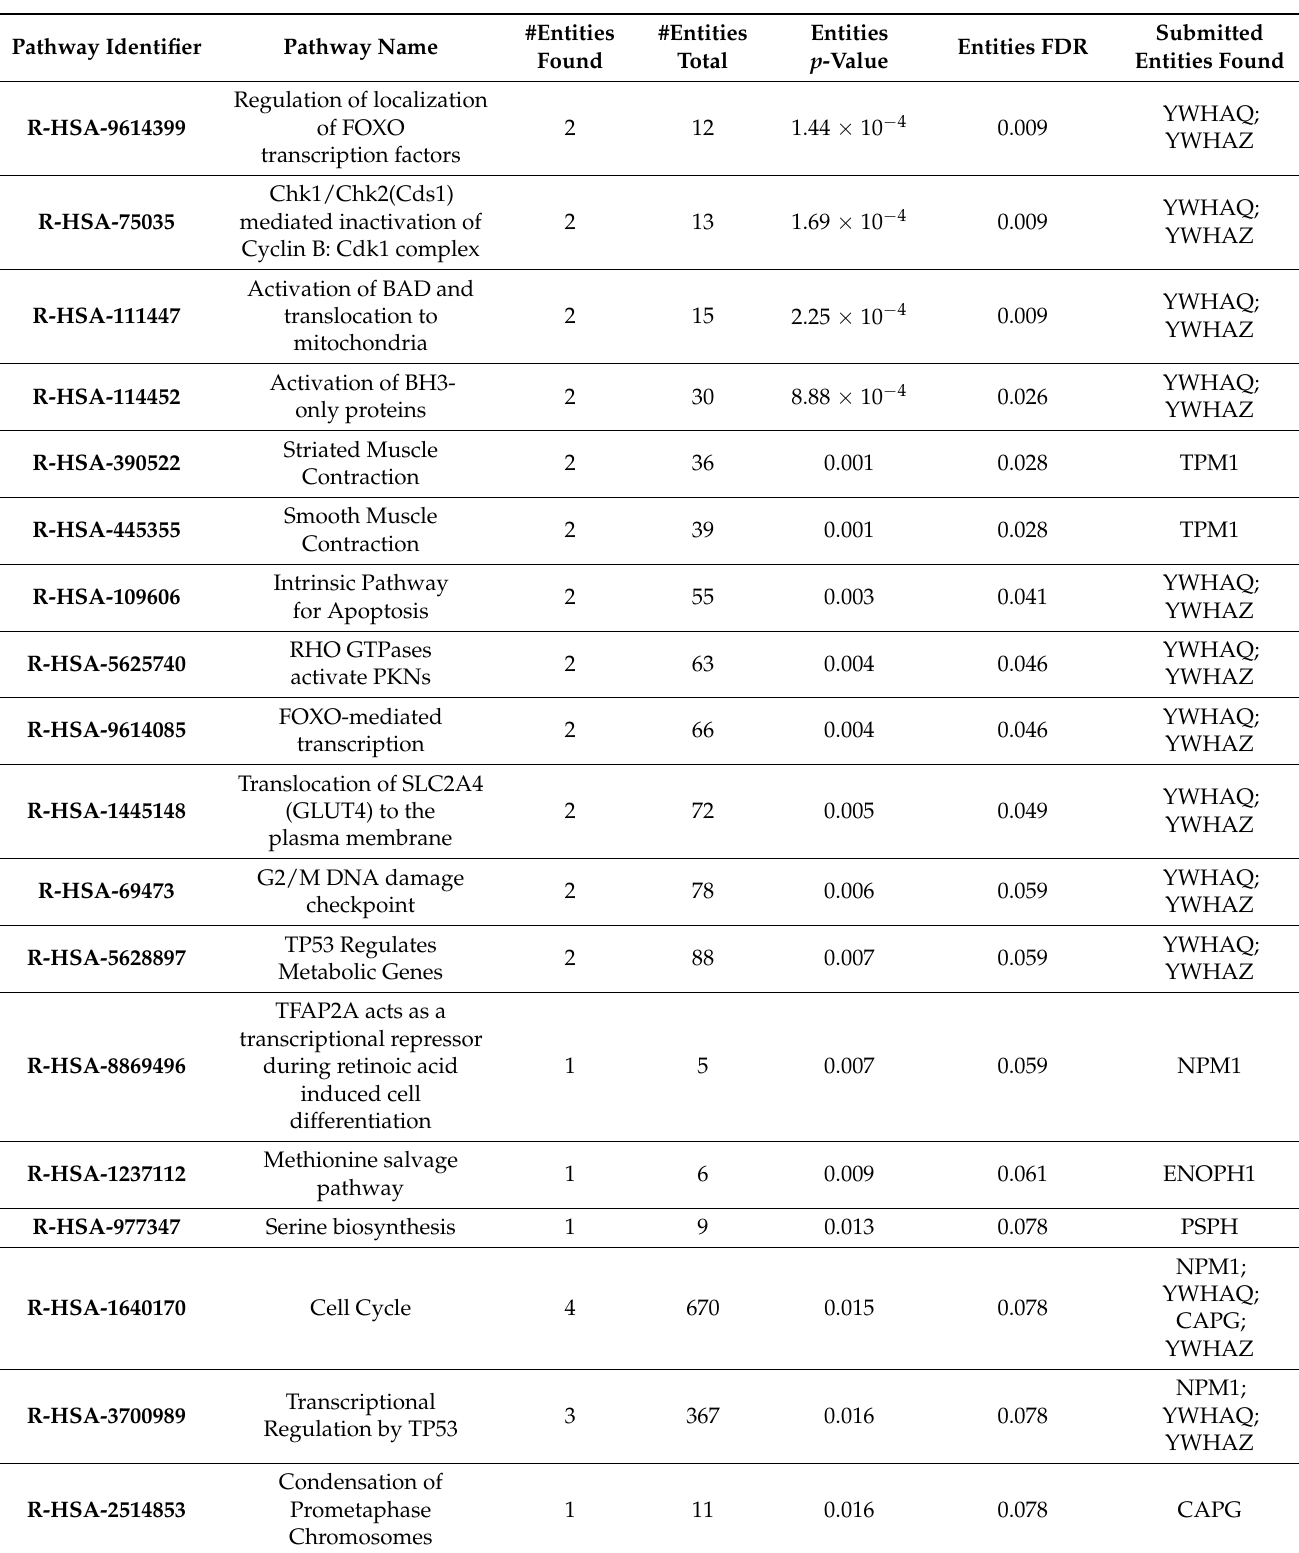
Table 3. Pathway enrichment analysis of up-regulated proteins in BRAFV600E mutant HT-29 colon cancer cells using the Reactome Pathway